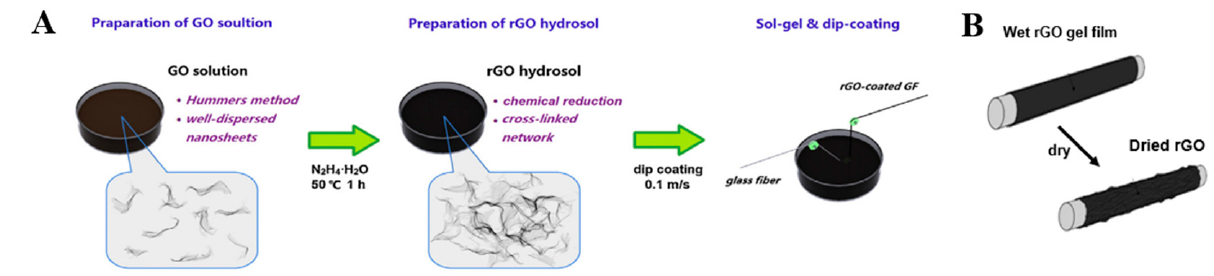
Figure 7. ( A ) Preparation schematic of graphene − coated GFs through sol-gel and dip − coating techniques. ( B ) Formation of the wrinkled rGO coatings onto GFs. Reproduced with permission from reference [87]. Copyright 2019 Journal of Materials Science & Technology .